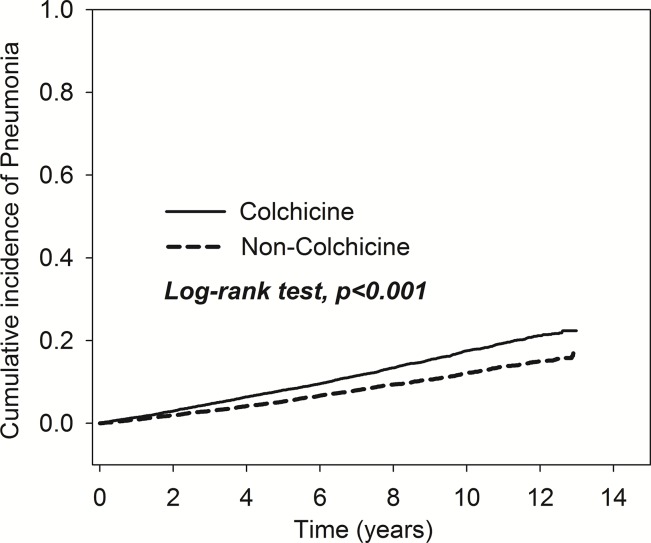
Comparison of cumulative incidences of pneumonia in the patients with and without taking colchicine.